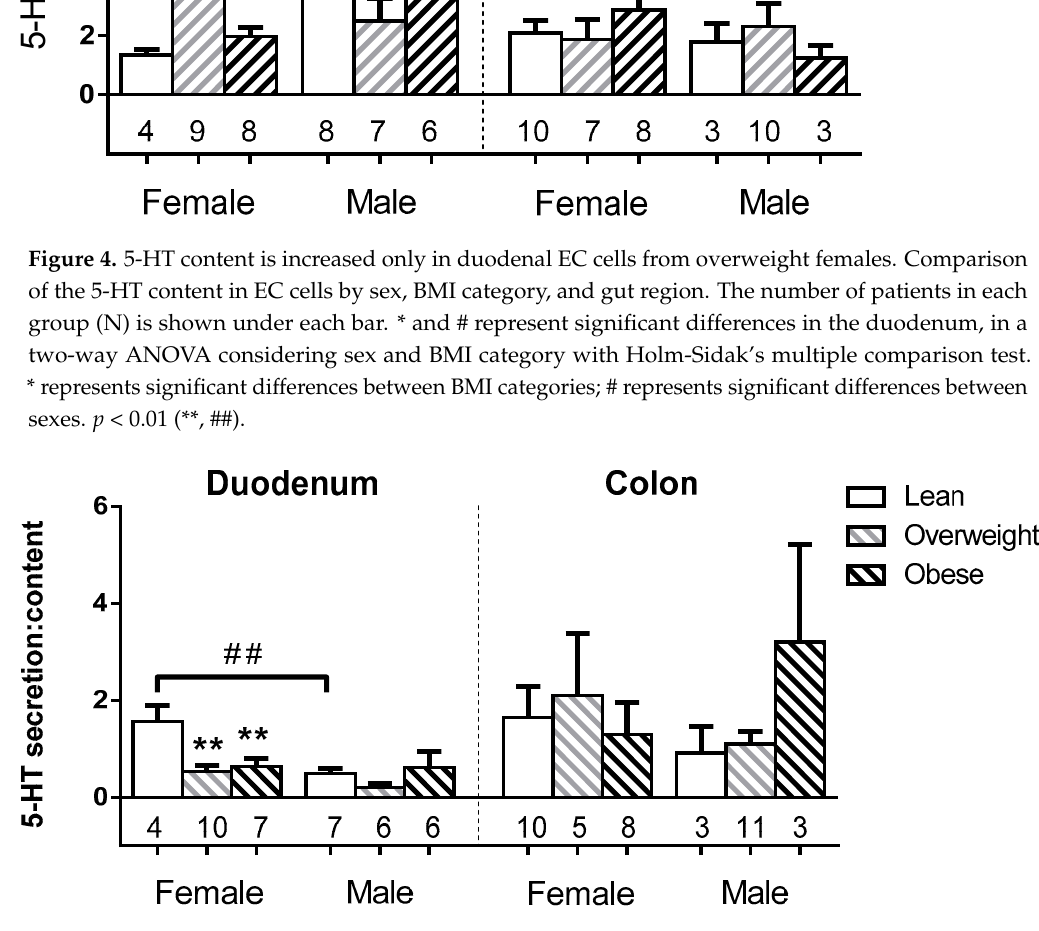
Figure 5. Duodenal EC cells from lean females are more sensitive to glucose-evoked 5-HT release than those from non-lean females, or lean males. The number of patients in each group ( N ) are shown under each bar. * represents significant BMI-related differences compared to the corresponding lean group; # represents significant differences between sexes. p < 0.01 (**, ##).